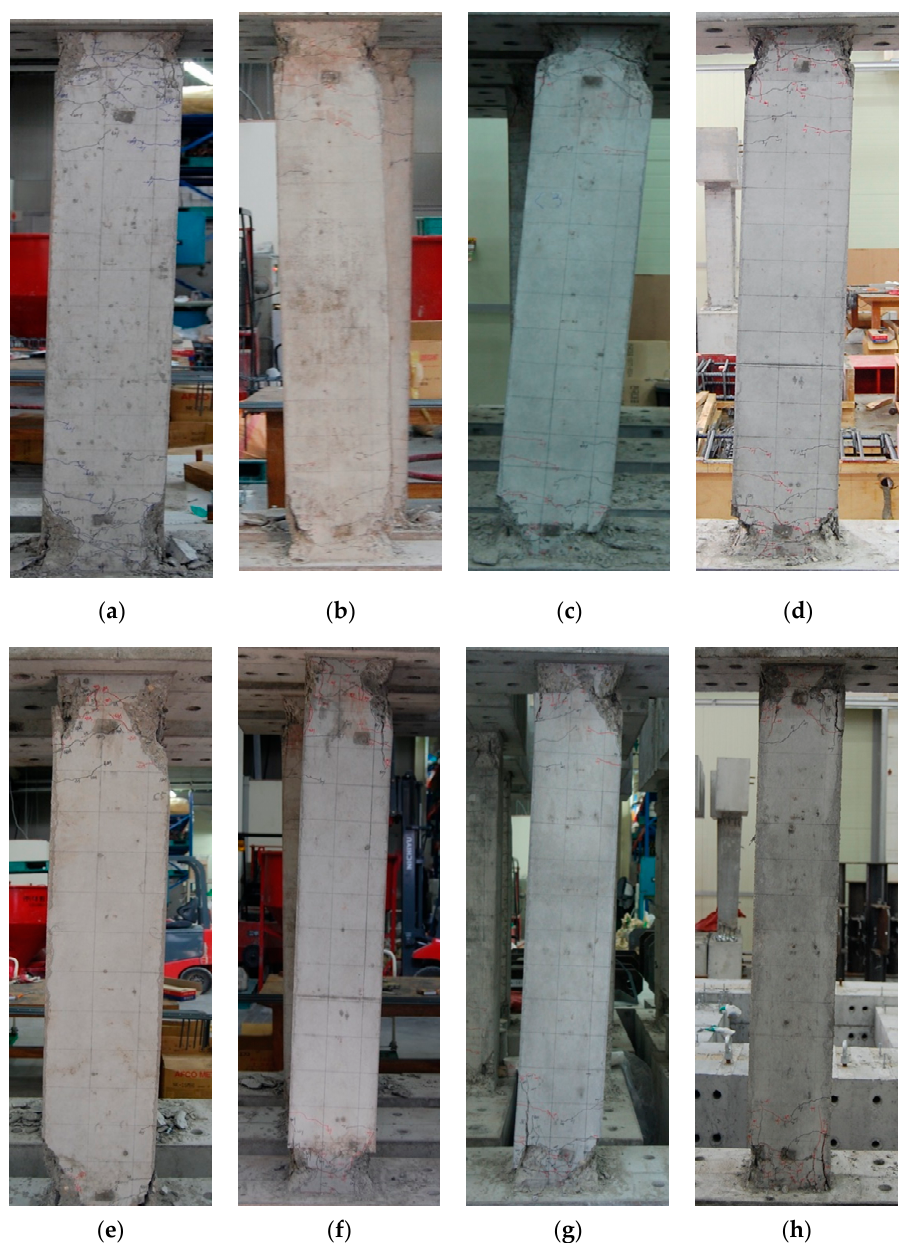
Figure 6. Failure mode of specimens: ( a ) NH20; ( b ) NH30; ( c ) UH20; ( d ) UH30; ( e ) NS20; ( f ) NS30; ( g ) US20; ( h ) US30.